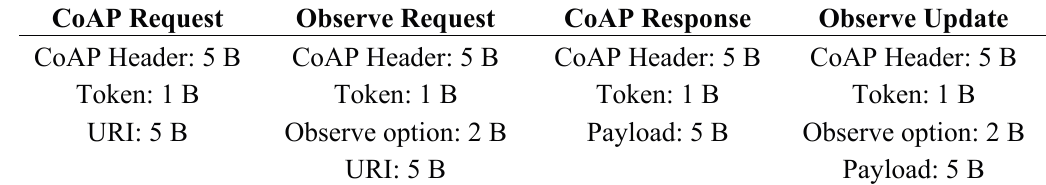
Table 1. Composition and length, in Bytes, of the messages interchanged between the CoAP proxy and the CoAP